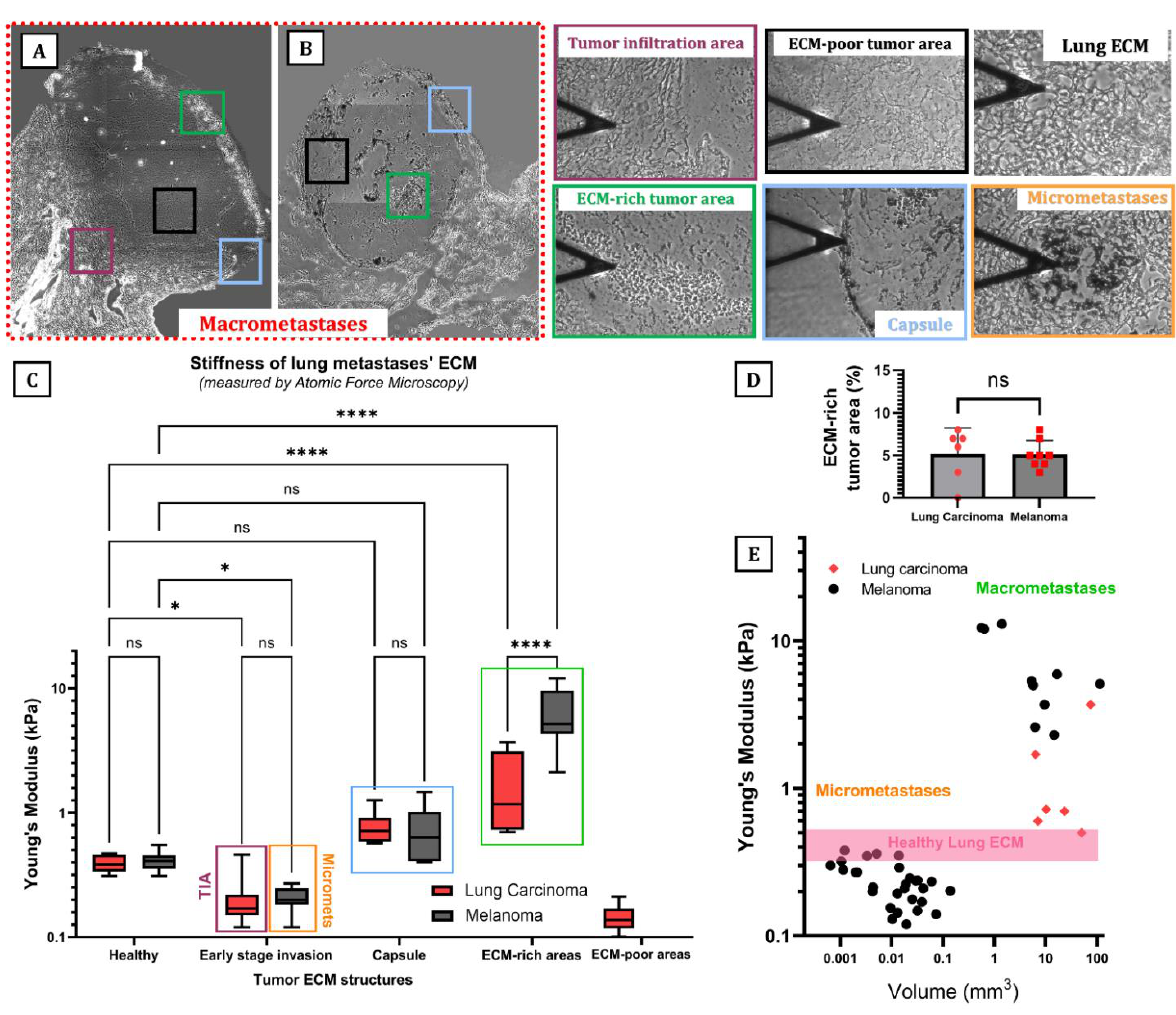
Figure 2. Structure and mechanics of the decellularized ECM of lung carcinoma (LC) and melanoma (MEL) lung metastases. ( A,B ) Lung carcinoma and melanoma decellularized metastases, respec- tively. Different ECM structures are marked with different coloured selections: green—ECM-rich regions; blue—ECM capsule; black—ECM-poor regions; purple—tumor-infiltration area (TIA); orange—micrometastases. ( C ) Young’s modulus (kPa) of each ECM structure of LC and MEL metas- tases, measured by atomic force microscopy. ( D ) ECM deposition measured by the area tumor area occupied by the ECM-rich areas, where the total tumor area was normalized to 100%. ( E ) Relation- ship between Young’s modulus (kPa) and estimated volume (mm 3 ) of metastases. p -values were obtained using a two-way analysis of variance (ANOVA) with Tukey post hoc multiple comparisons. (ns, * p -value > 0.05, p -value < 0.05, ****, p <